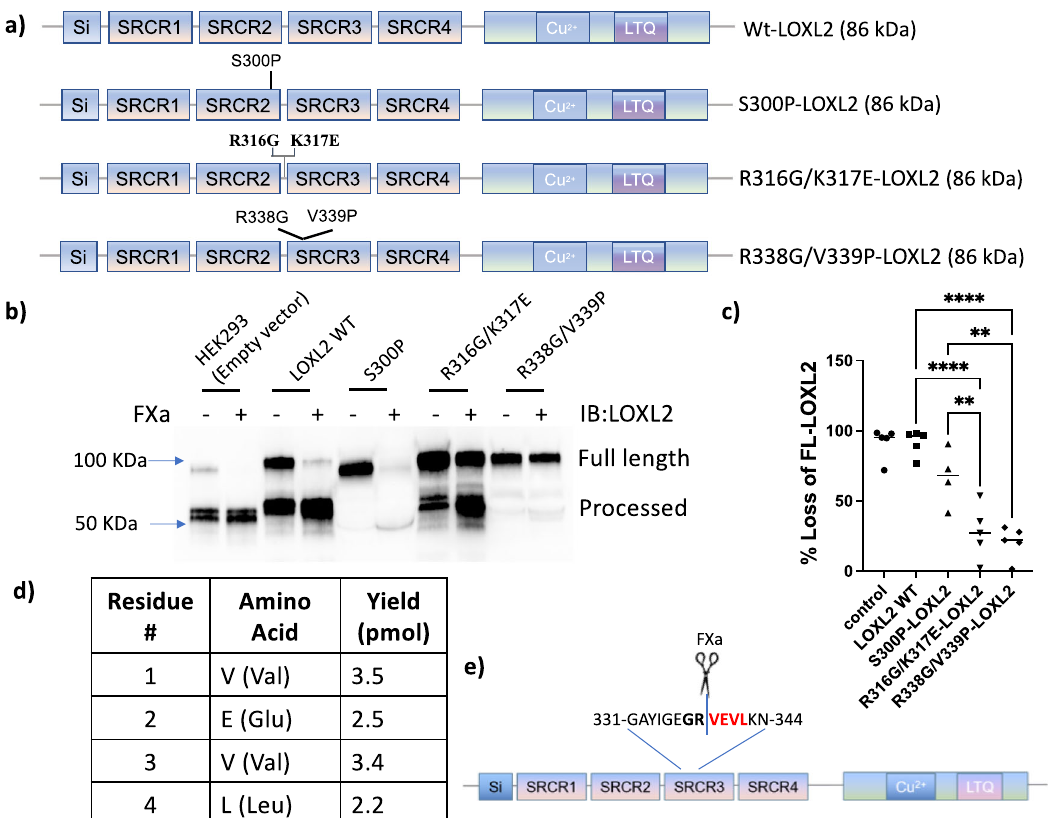
Fig. 4 FXa processes LOXL2 at R338G. Conditioned media containing wild-type and mutant LOXL2 were incubated with FXa (1 μ g/ml) for 2 h. a Schematic of LOXL2 mutants with predicted molecular weight in parenthesis. b , c Conditioned media containing similar levels of overexpressed LOXL2 mutants were incubated with and without FXa for 2 h. Proteins from conditioned media were then enriched with StrataClean Resin and LOXL2 processing was evaluated by western blotting. b Representative western blot and c densitometry analysis of FXa mediated processing of WT-LOXL2, S300P-LOXL2, R316G/K317E-LOXL2, and R338G/V339P-LOXL2. ( n = 5; ** P < 0.01, **** P < 0.0001 by one-way ANOVA). d , e C-terminal His-Tagged LOXL2 was incubated with FXa. The resulting C-terminus fragment was enriched using His-Talon beads and sequenced by Edman degradation. d Table showing the fi rst 4 amino acids of the processed (~65 kDa) C-terminus fragment of LOXL2 and e schematic depicting the FXa processing site of